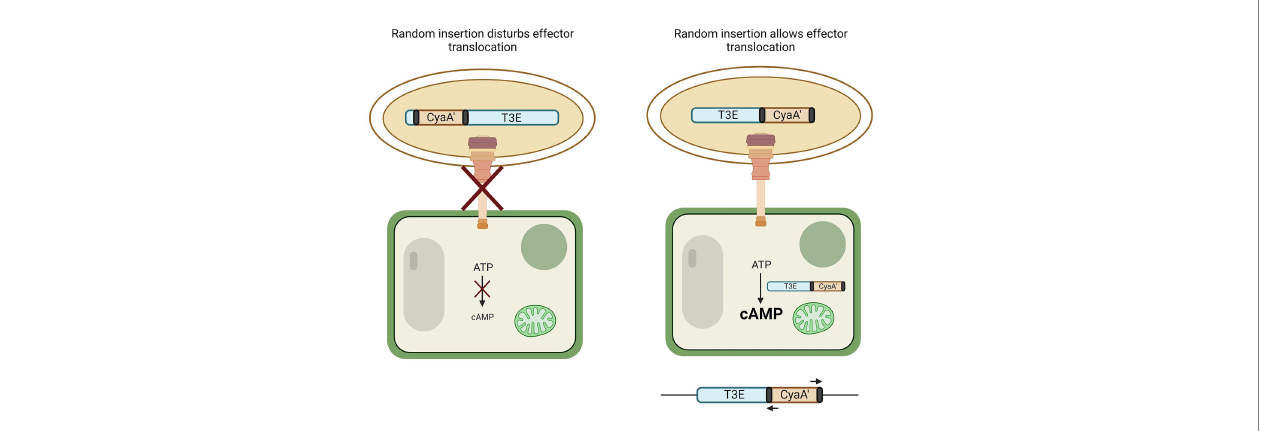
FIGURE 2 CyaA’ translocation assay to discover T3Es. By means of transformation, the N-terminal part of the calmodulin-dependent adenylate cyclase gene ( cyaA’ ) is randomly inserted into the genome of the bacterium. If genomic insertion disturbs effector translocation to the plant cell via the T3SS, no change in cyclic AMP (cAMP) occurs (left). However, if random insertion allows translocation to the plant cell, CyaA’ converts ATP to cAMP (right). The genome of bacteria that induced plant cAMP levels can then be queried for the presence of an effector by use of primers binding to the transposon elements flanking the cyaA’ gene